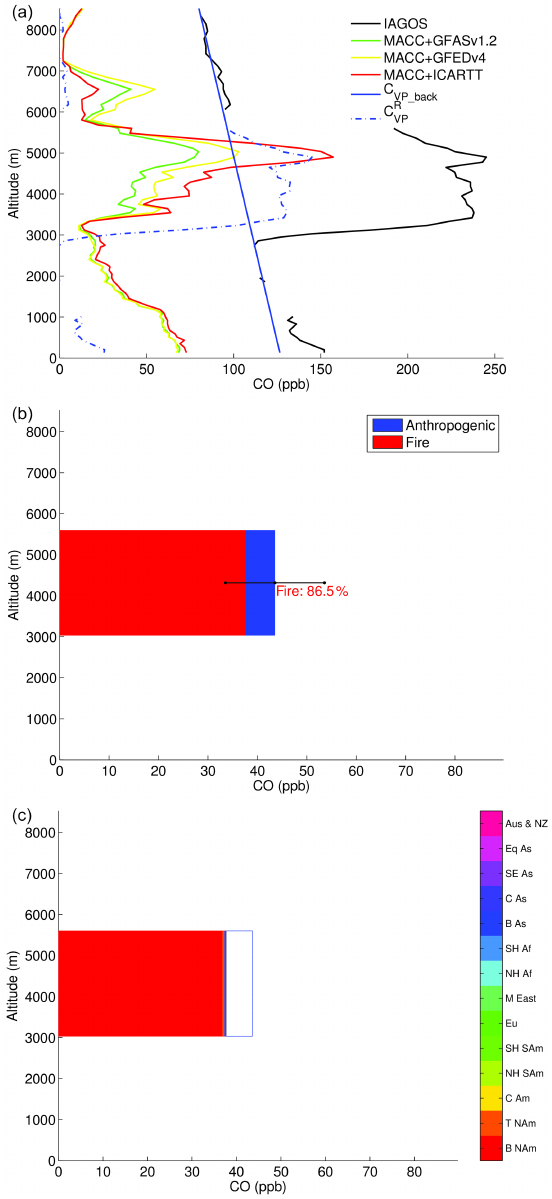
Figure 7. (a) Carbon monoxide profiles over Paris during a MOZAIC–IAGOS flight landing on 22 July 2004. The black line indicates the observed CO profile and the blue line indicates CO background deduced from the observations. Green, yellow and red lines indicate the simulated contributions using, respectively, GFAS v1.2, GFED4 and ICARTT for biomass burning emissions, with MACCity for anthropogenic emissions. Simulated CO is separated into (b) source contribution (anthropogenic in blue, fires in red, standard deviation in black) and (c) regional biomass burning ori- gins (14 regions defined for global emission inventory, http://www. globalfiredata.org/data.html see Fig. S1; unshaded blue square is for anthropogenic contribution), using MACCity and GFAS v1.2.